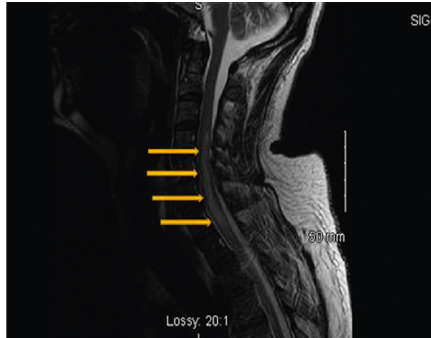
Figure 1: A sagittal T-weighted MRI of the C-spine of the patient on April 28, 2017, before the antifungal treatment. The arrows point to the spinal cord lesion due to coccidioidal